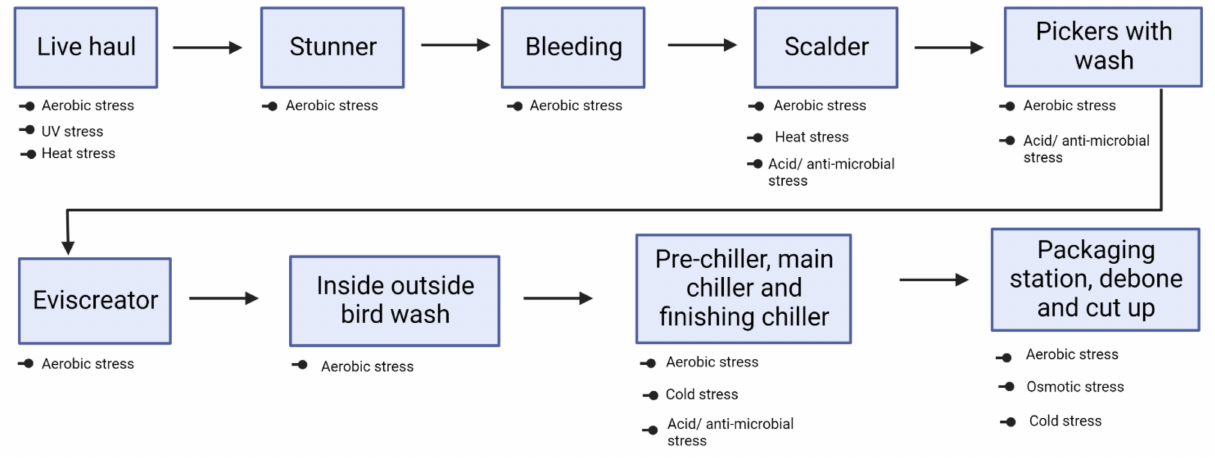
Figure 1. Potential stressors encountered by C. jejuni at various stages of broiler processing